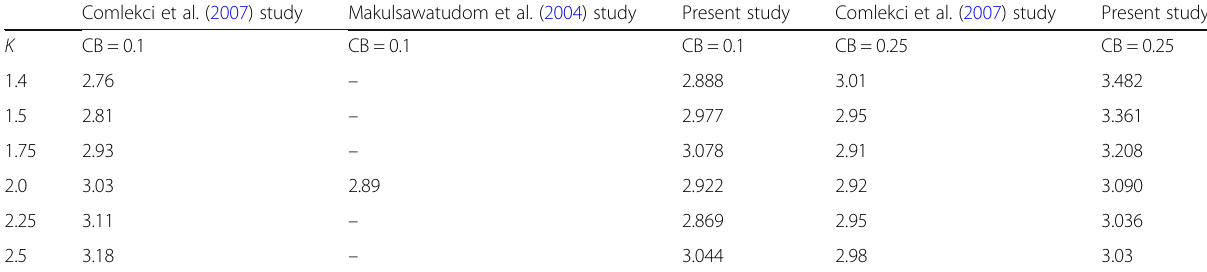
Table 3 Comparison of stress concentration factors for radial cross bores Comlekci et al. (2007) study